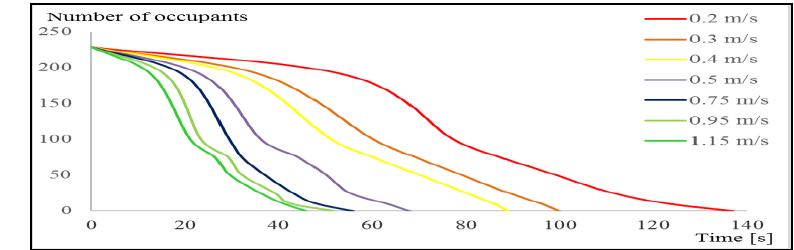
Figure 14 – Simulation results for the fastest times of the third case of the second scenario